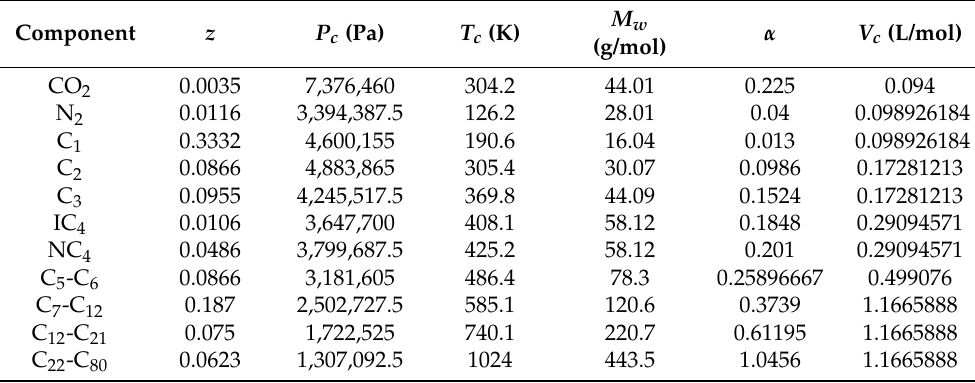
Table 3. PVT critical properties of the reservoir hydrocarbon fluid (partially from [38]).